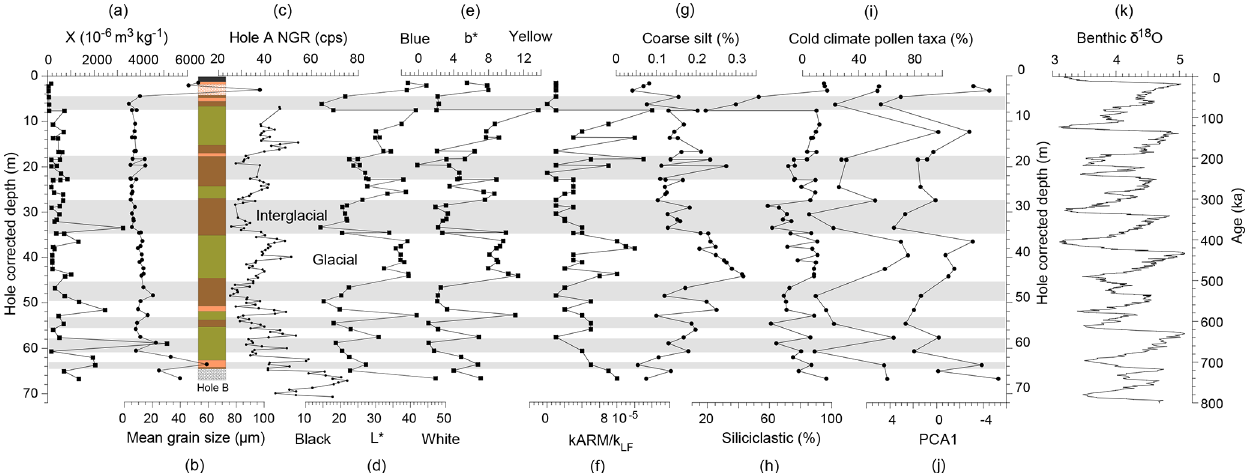
Figure 8. Selected parameters of the pilot multi-proxy analyses. (a) Mass-normalised magnetic susceptibility ( χ ), (b) mean grain size, (c) Natural gamma ray (NGR), (d) Color data L ∗ and (e) b ∗ , (f) Magnetic grain-size indicator kARM /k LF , (g) coarse silt, (h) silici- clastic content, (i) cold climate pollen taxa, and (j) PCA axis 1 from left (warm) to right (cold). The starting and ending ages of the Darwin lacustrine sediment succession are unknown and will be identified by ongoing dating work. (k) A benthic δ 18 O stack (Lisiecki and Raymo, 2005) is shown as a reference for Pleistocene glacial and interglacial climate cycles. A simplified lithology log for Hole B is included. The horizontal grey shaded bars tentatively indicate interglacial periods. Different symbols are used for different sample types: square symbols for measurements performed on the same cube samples, large circles for core end samples, and small circles for whole core MSCL